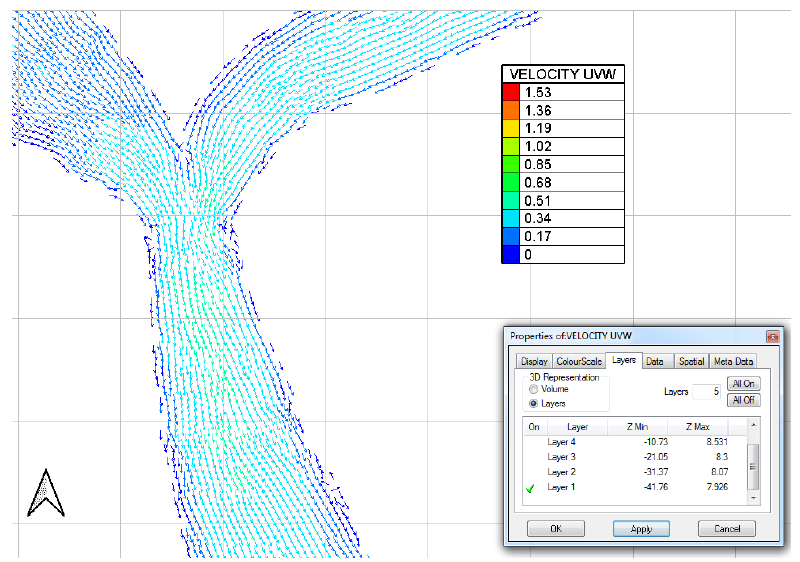
Figure 9. Average flow velocity (VELOCITY UV) in the dry season in 2017 at the bottom (m/s).